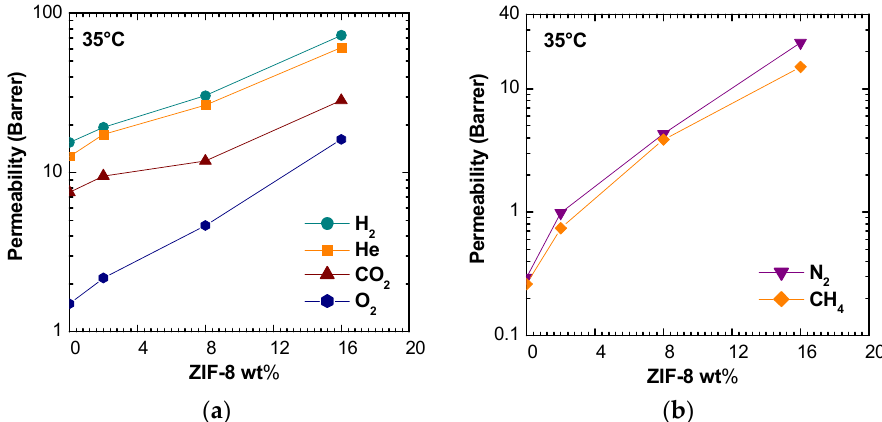
Figure 5. Permeability of various gases in PSf/ZIF-8 mixed matrix membranes as a function of ZIF-8 wt%: ( a , b ) at 35 °C.